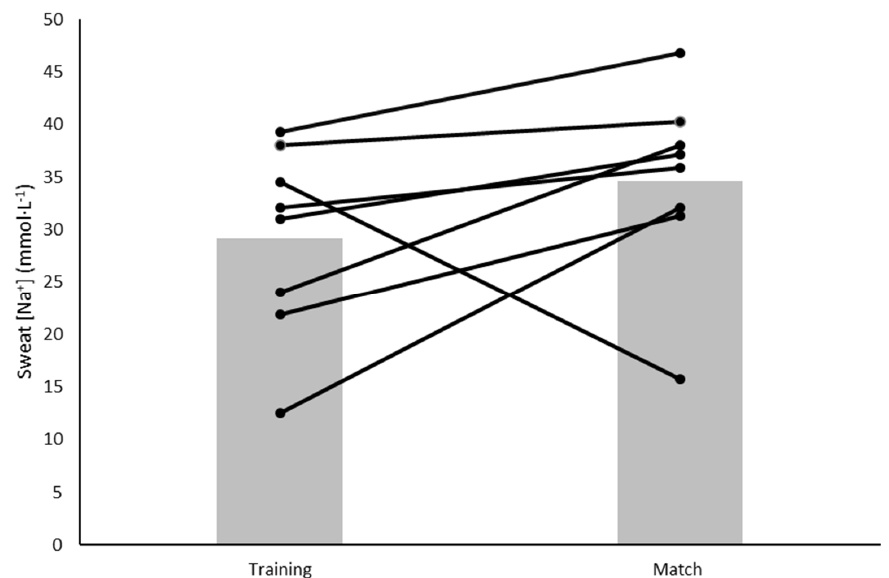
Figure 2. Individual and mean sweat [Na + ] (mmol · L − 1 ) during the training session and match. Black lines = individual data, grey bars = mean.